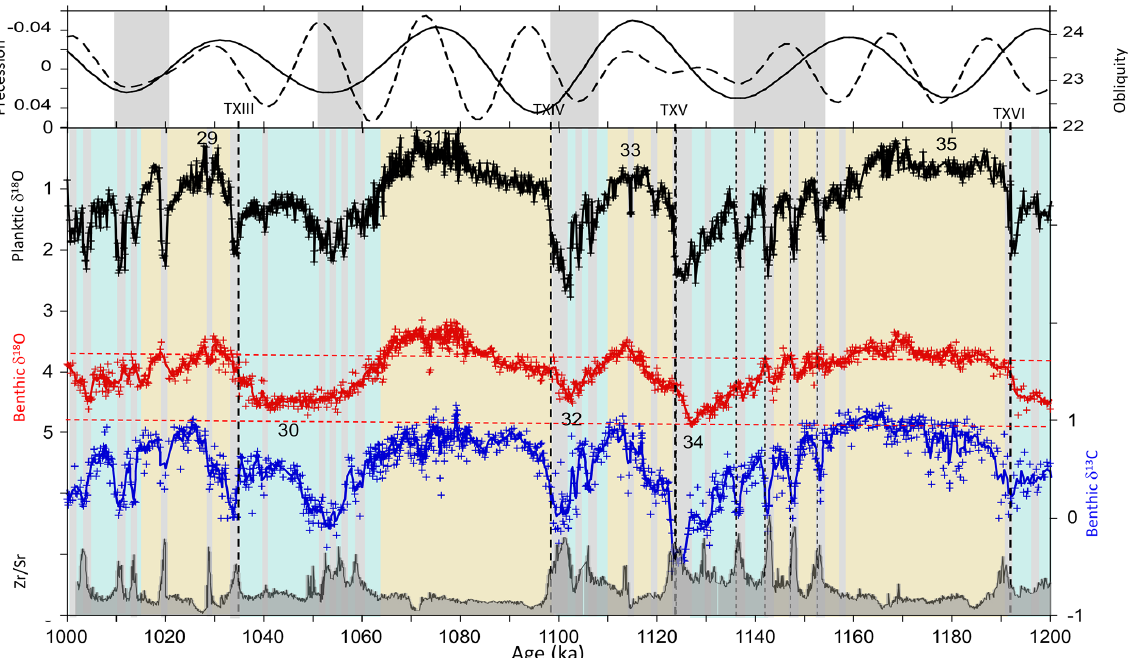
Figure 11. Same as Fig. 6 but for 1000–1200ka. Note the very strong MCV on the MIS 35–34 transition associated with declining obliquity.